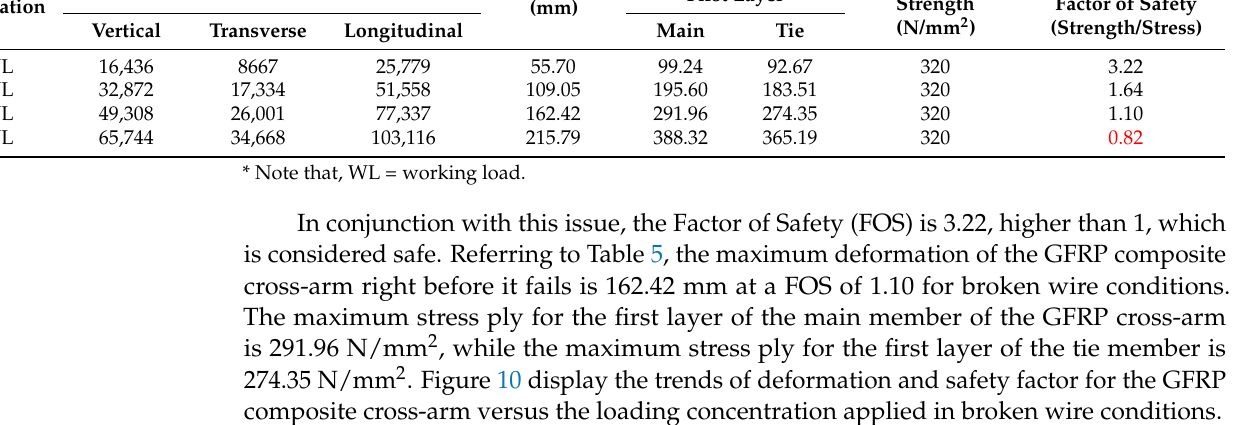
Figure 8. ( a ) Equivalent stress ply first layer of the main member ( b ) Equivalent stress ply first layer of tie member.